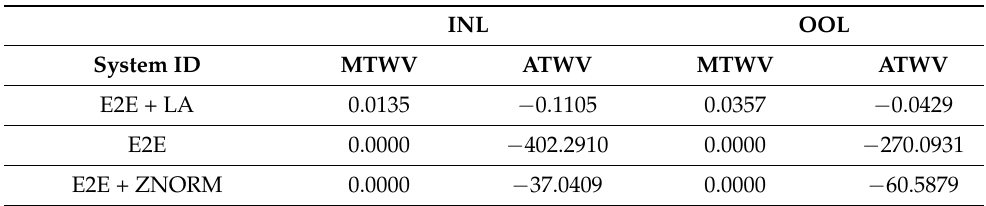
Table 23. System results of the QbE STD task for MAVIR test data for in-language (INL) and out-of-language (OOL) queries.